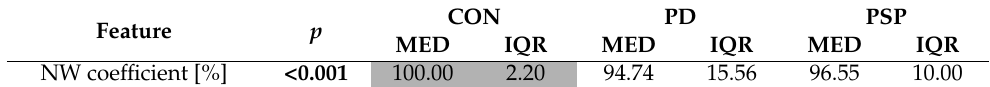
Table A5. Results of the Kruskal–Wallis ANOVA for the whole series. Statistically significant values in bold ( p < 0.05). The group with mean ranks significantly different from others is marked in